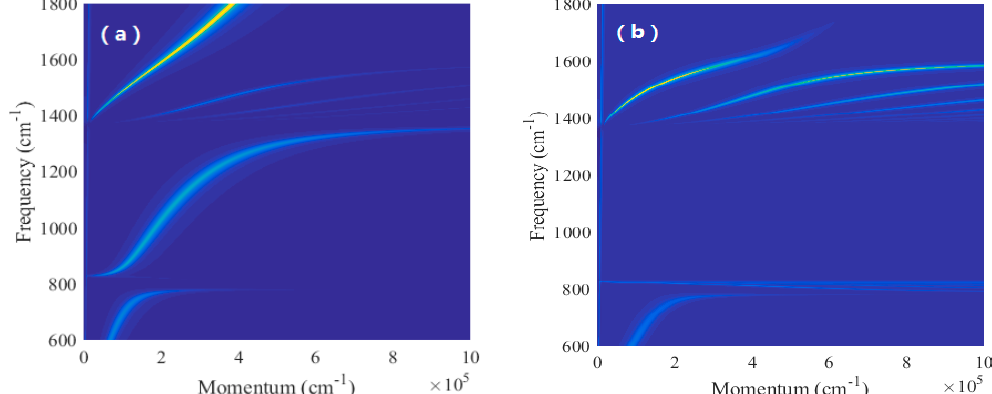
Figure 6. The effect of the Fermi energy of graphene on transmission properties. ( a ) SPPs excited first and ( b ) HPPs excited first. Here, the Fermi energy of graphene and the thickness of the h-BN slab are 0.8 eV and 50 nm, respectively.